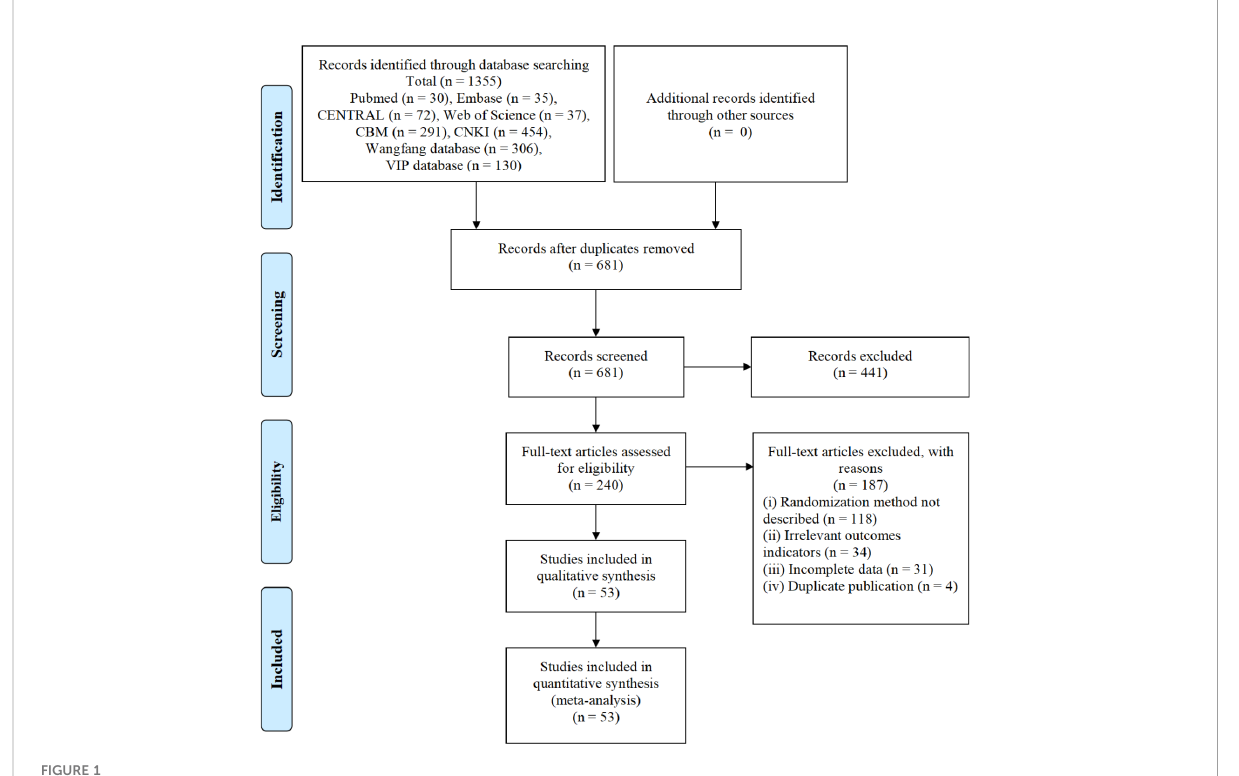
FIGURE 1 Flowchart of the selection